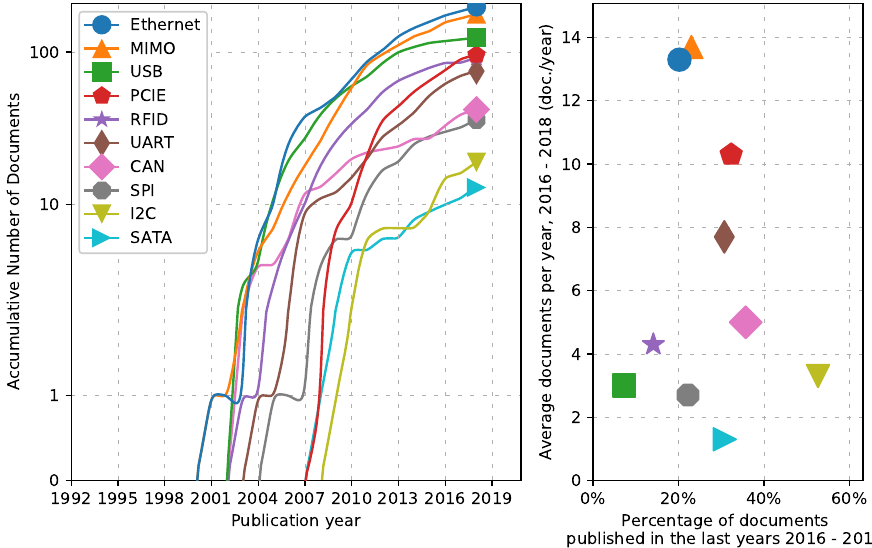
Figure 5. Serial communication interfaces top implementations in FPGA